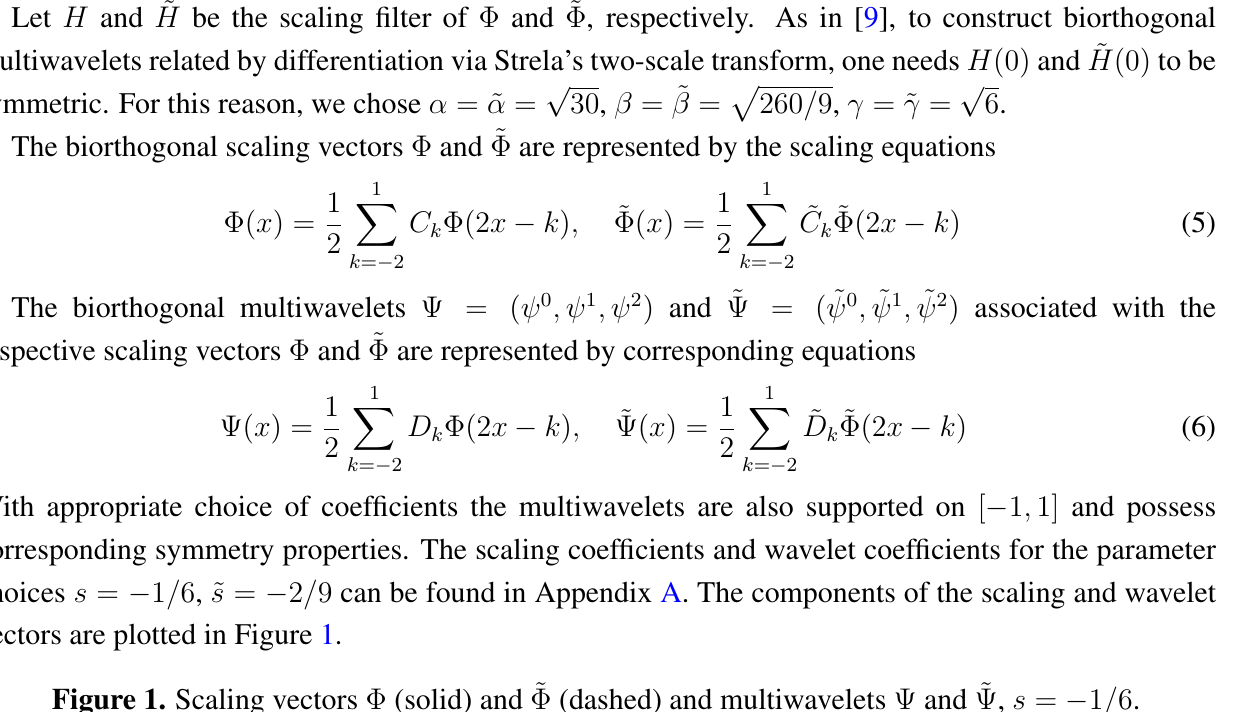
Figure 1. Scaling vectors Φ (solid) and ˜ Φ (dashed) and multiwavelets Ψ and ˜ Ψ , s = − 1 / 6